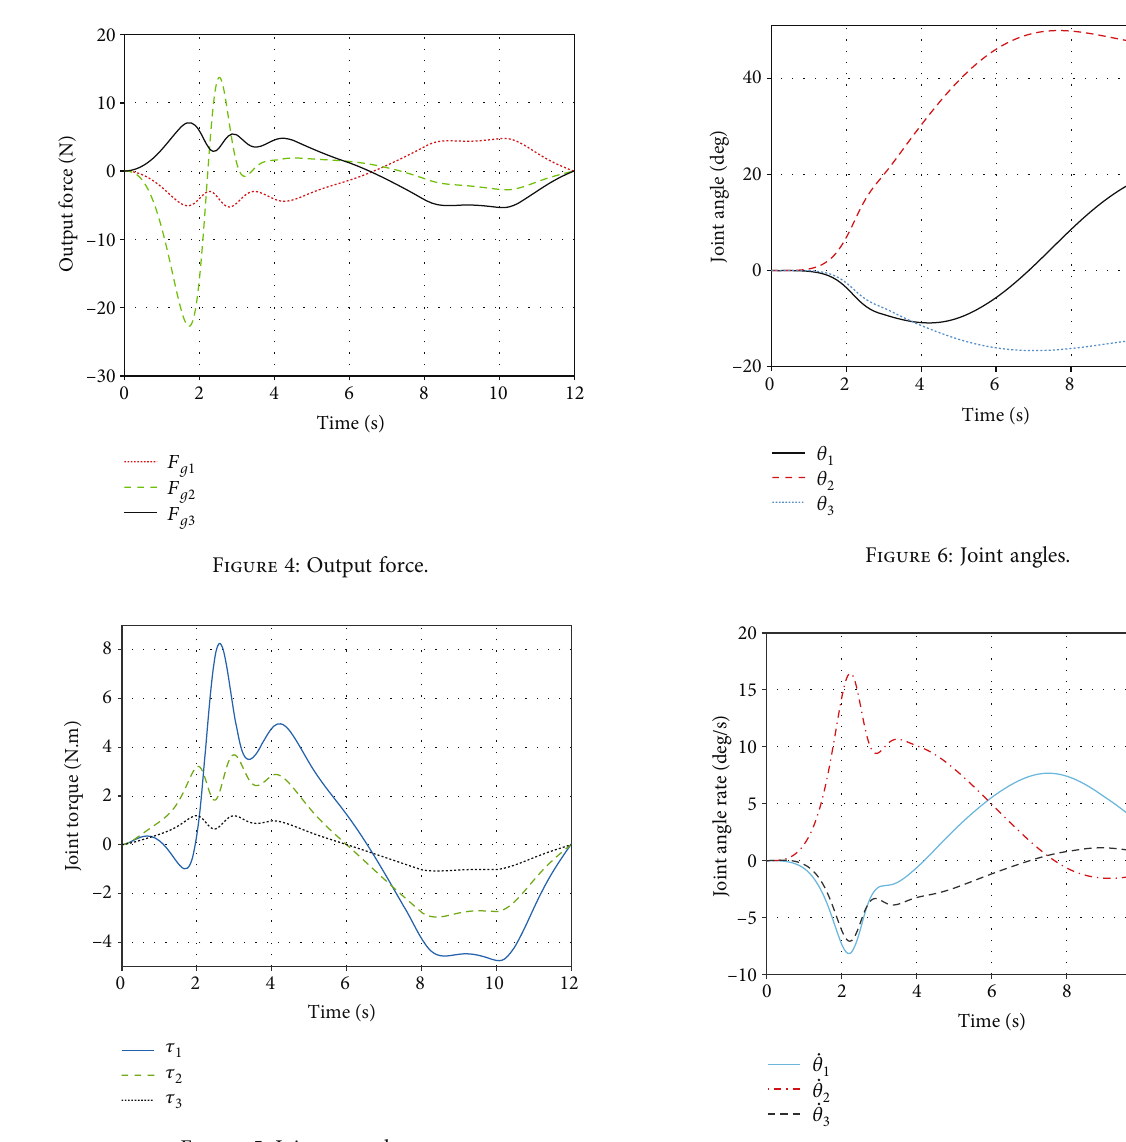
Figure 7: Angular velocity.